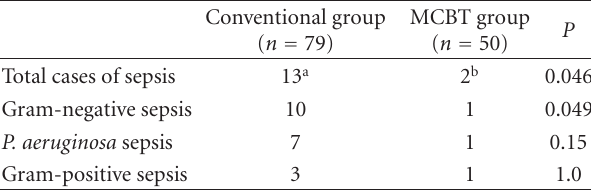
Table 2: Causes of post-lung-transplant